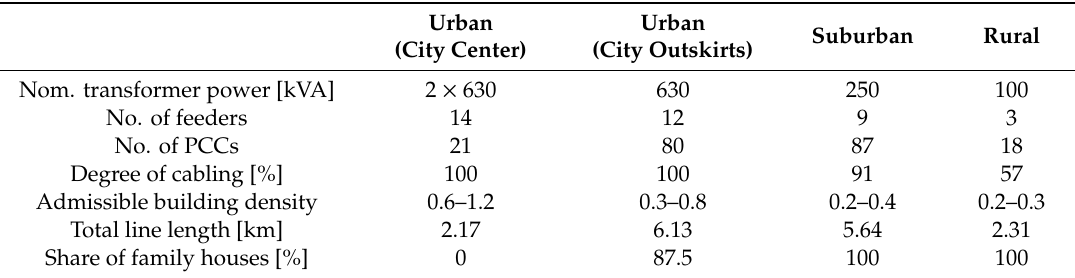
Table 1. Grid configurations depending on the grid region.